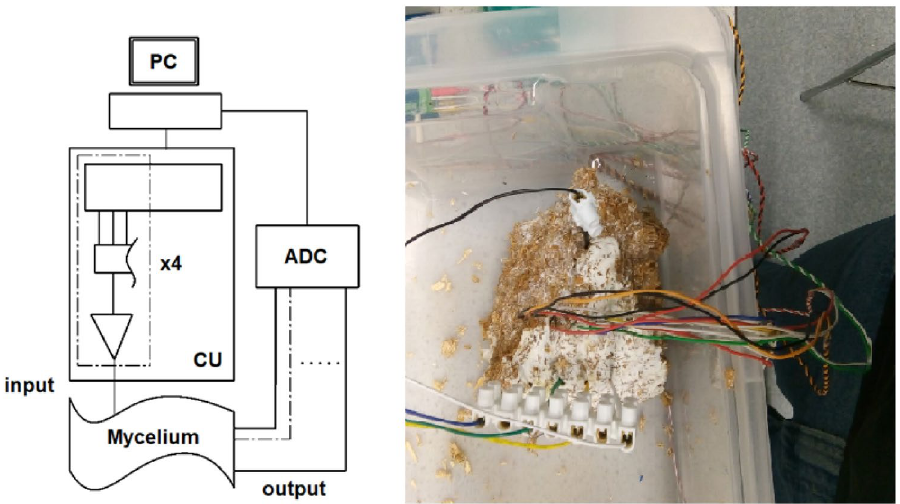
Figure 1. Left: Schematic of the mycelium communications system; PC – laptop for generating sequences; CU – control unit, dashed section is a breakdown of a single channel; ADC – analogue to digital converter. Right: experimental set up.